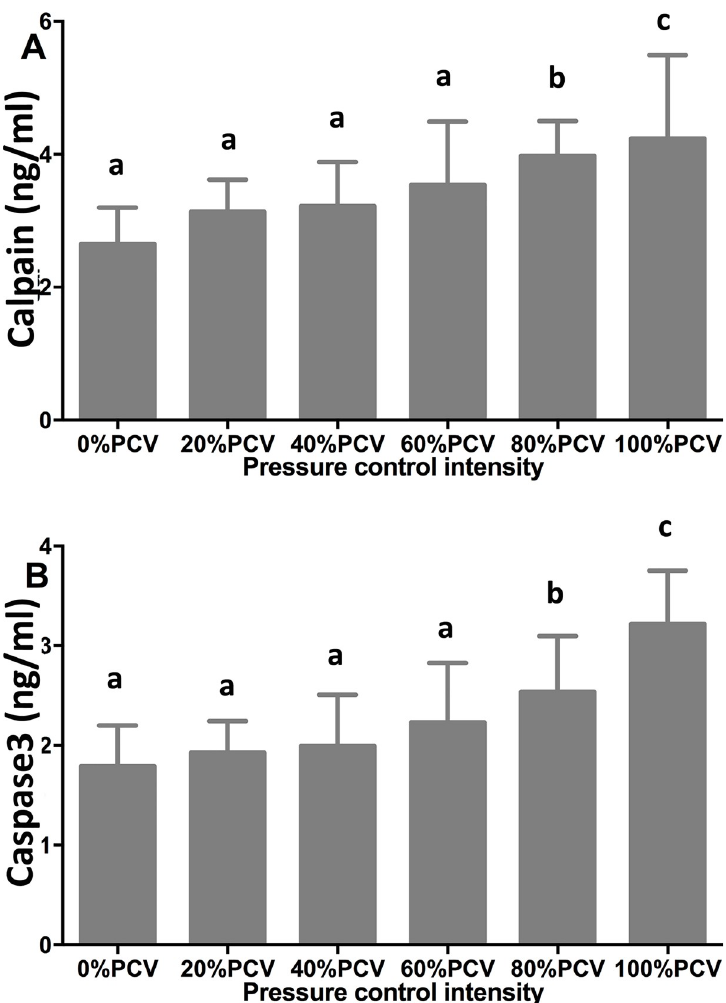
Fig 4. Levels of diaphragmatic calpain (A) and caspase3 (B) after 24-h controlled mechanical ventilation at different